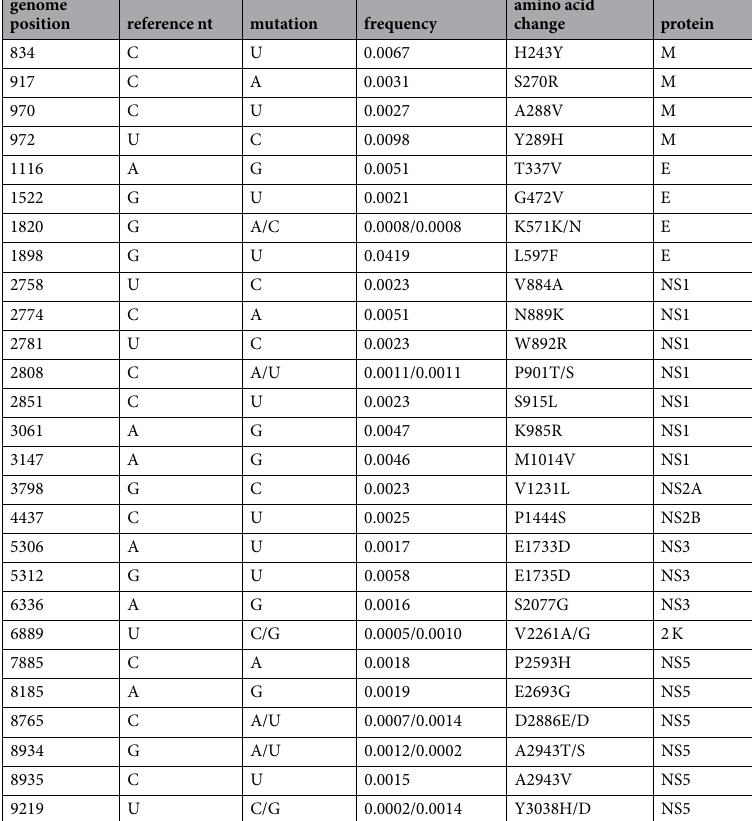
Table 1. Non-synonymous SNVs in the ZIKV SL1602 quasispecies